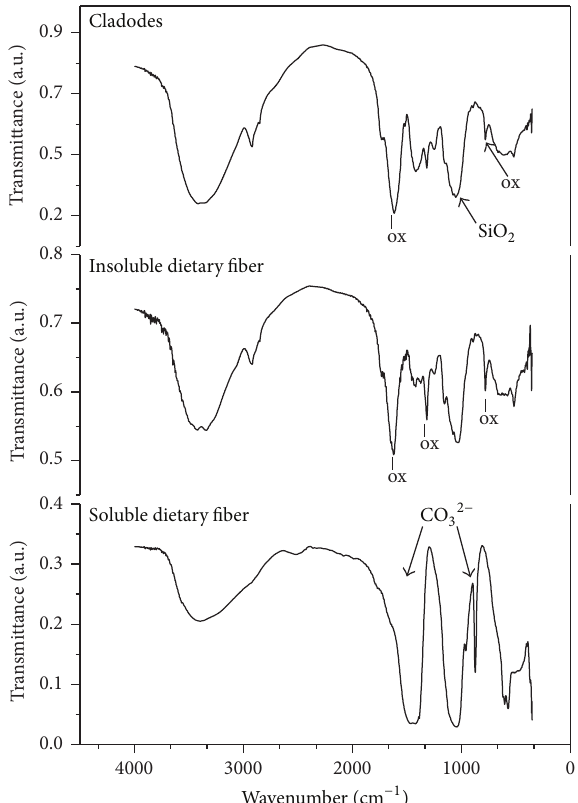
Figure 4: Infrared spectra of Opuntia ficus indica samples (cladodes, insoluble, and soluble dietary fiber). ox: CaC 2 O 4 ⋅ H 2 O (whewellite).